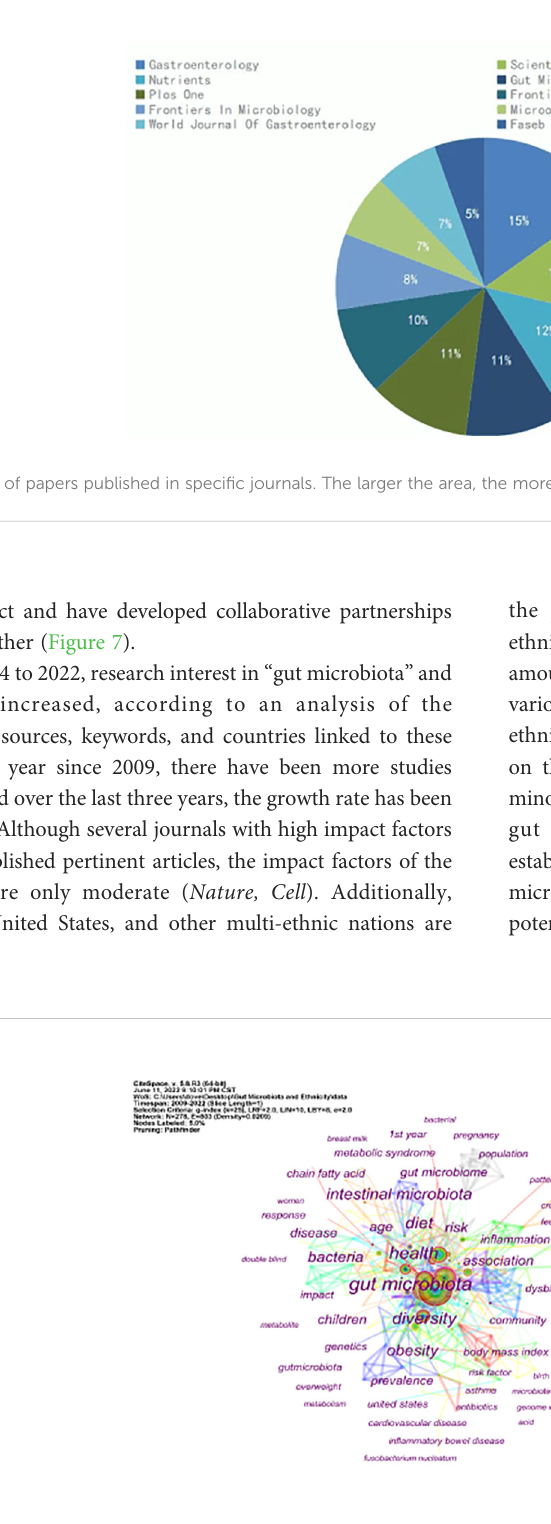
FIGURE 4 Keyword map for research on “ Gut Microbiota ” and “ Ethnicity ” conducted from 1984 to 2022. The larger the keyword node, the stronger its neutrality. The line of nodes represents the co-occurrence relationship, the thickness of the line.indicates the intensity of co-occurrence.The color from gray to red indicates the time from early to